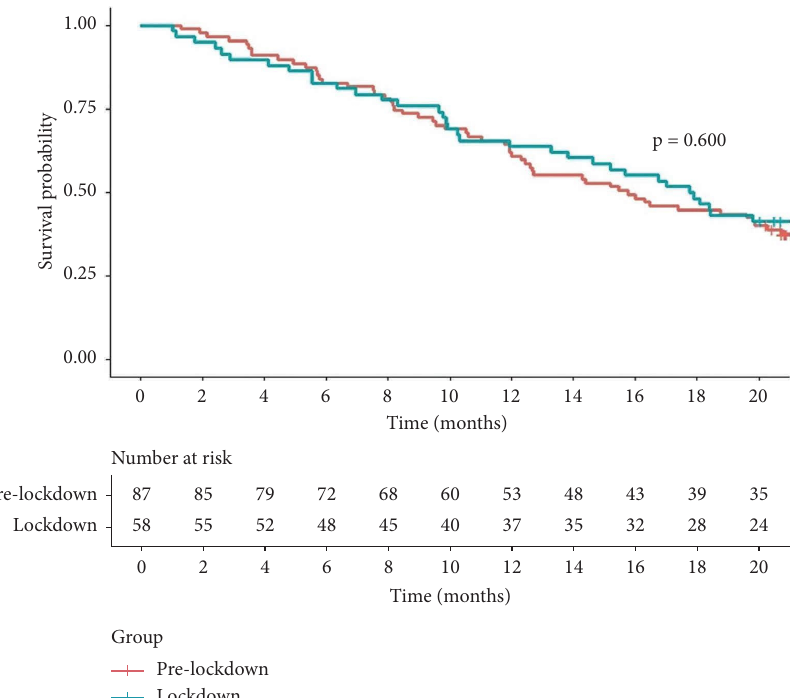
Figure 2: Cumulative survival of HCC patients who underwent repeated transarterial chemoembolization (TACE) during the prelockdown and lockdown periods. Table 5: Univariate and multivariate logistic regression analyses exploring factors associated with survival after chemoembolization. Univariate analysis Multivariate Prognostic factors Reference